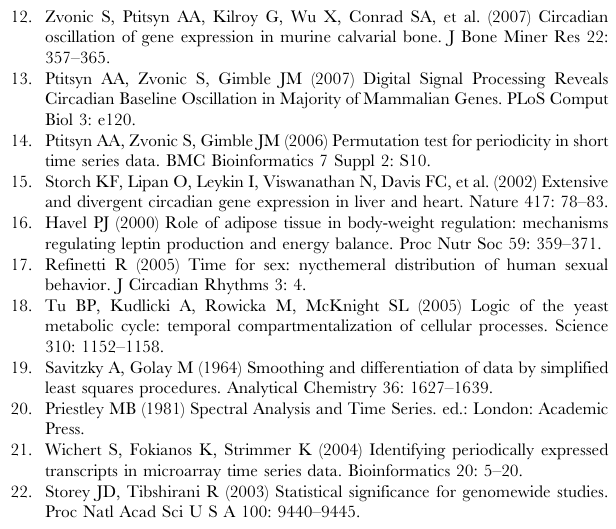
Figure S1 Illustration of the principal of stochastic resonance. A periodic signal could be too weak to be detected by existing methods (A). The threshold for a detector can be selected so that a stochastic ambient noise is occasionally detected. The occurrence of stochastic noise exceeding the detection threshold is non- periodic (B). However, in presence of both stochastic noise and a weak periodic signal (C) there is a higher probability for the noise to be registered above threshold. Consequently, the occurrence of noise exceeding threshold becomes periodic and detection of this periodicity indicates the presence of baseline periodic signal. Figure S2 Heatmap of 323 transcripts (Affymetrix probesets) never called present at any time point. YG_S98 Affymetrix microarray has much fewer probesets compared to mouse expression arrays and almost all of these genes are found ‘‘present’’ or at least ‘‘marginal’’ at least once over the three periods of respiratory cycle. Only 323 genes are never called present. Pt-test indicates significant baseline oscillation with 3 periods within all profiles (36 time points each), although the pattern of 3 red zones is not obvious in all profiles. Only 3 transcripts show significant oscillation by fisher’s g-test (p , 0.1). These profiles are depicted on Supplemental Figure 3.